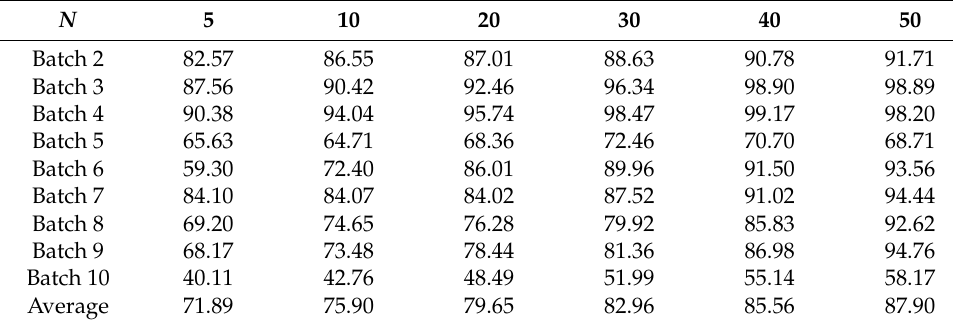
Table 7. Classification accuracy with different values of N on Setting